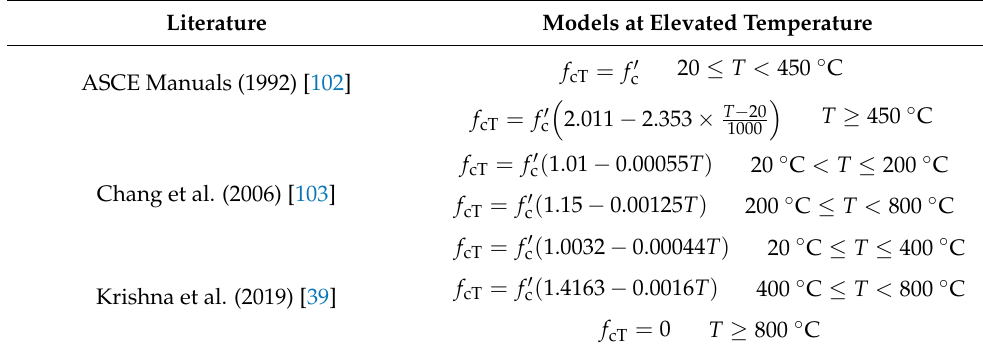
Table 1. Compressive strength models of concrete at high temperature.